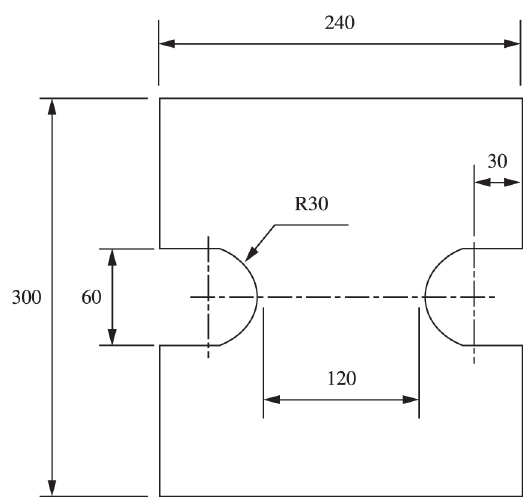
Figure 1. Sample geometry, used in the uniaxial tensile tests.